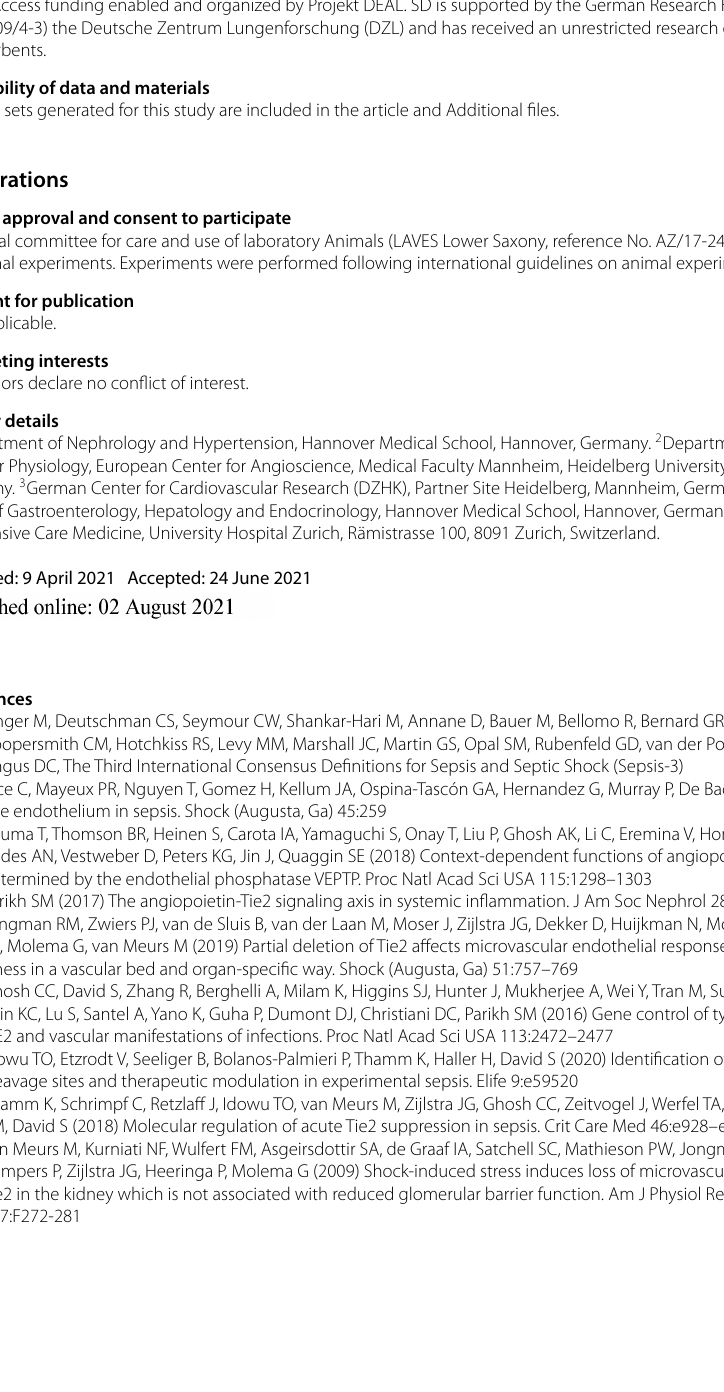
Additional file 7: Figure S7 . Hypotension suppresses endothelial KLF2 mRNA expression in various organs indicat- ing reduced flow in different vascular beds: Male C57bl/J6 mice, 10–12 weeks of age, were challenged with